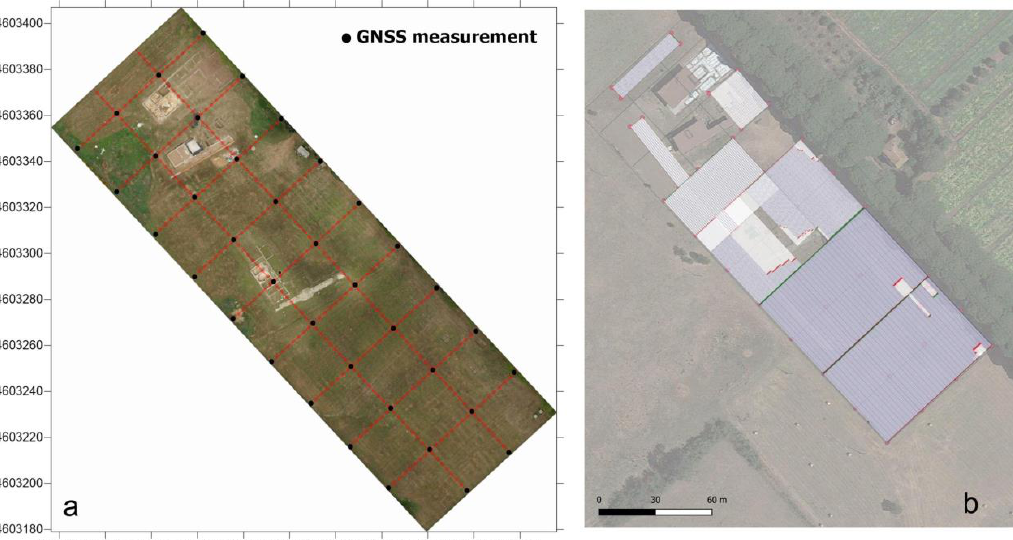
Figure 6. Comparison among radargrams before and after signal processing. ( a )-( a’ ) 200 MHz; ( b )- ( b’ ) 600 MHz.